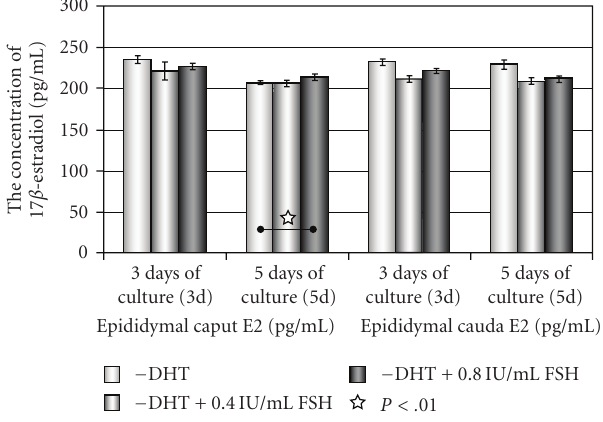
Figure 5: The concentration of 17 β -estradiol (E2) in media of epithelial cells of the caput and cauda epididymis cultured without DHT and stimulated with